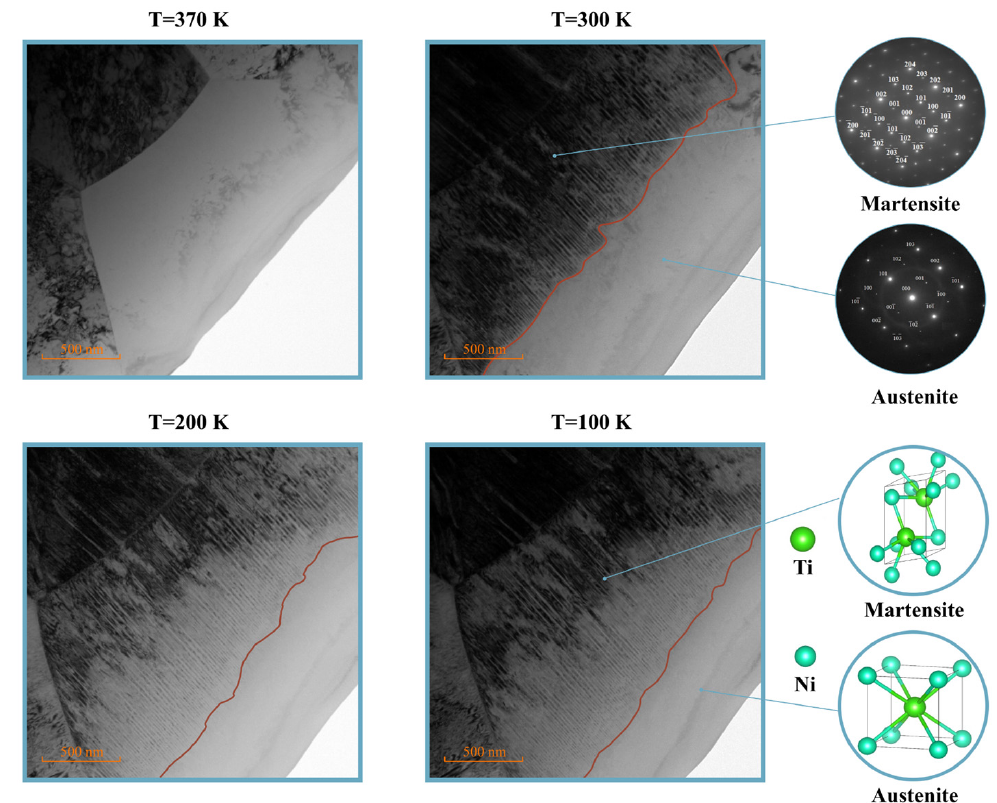
Figure 1. TEM image of a wedge-shaped TiNi sample with decaying thicknesses (from middle to edge) at room temperature. The boundary of the martensite-austenite transition with retained austenite at the edge is clearly visible in the TEM image of a wedge-shaped TiNi sample at different temperatures. Microdiffraction images and corresponding crystal structures are shown in the in- serts.